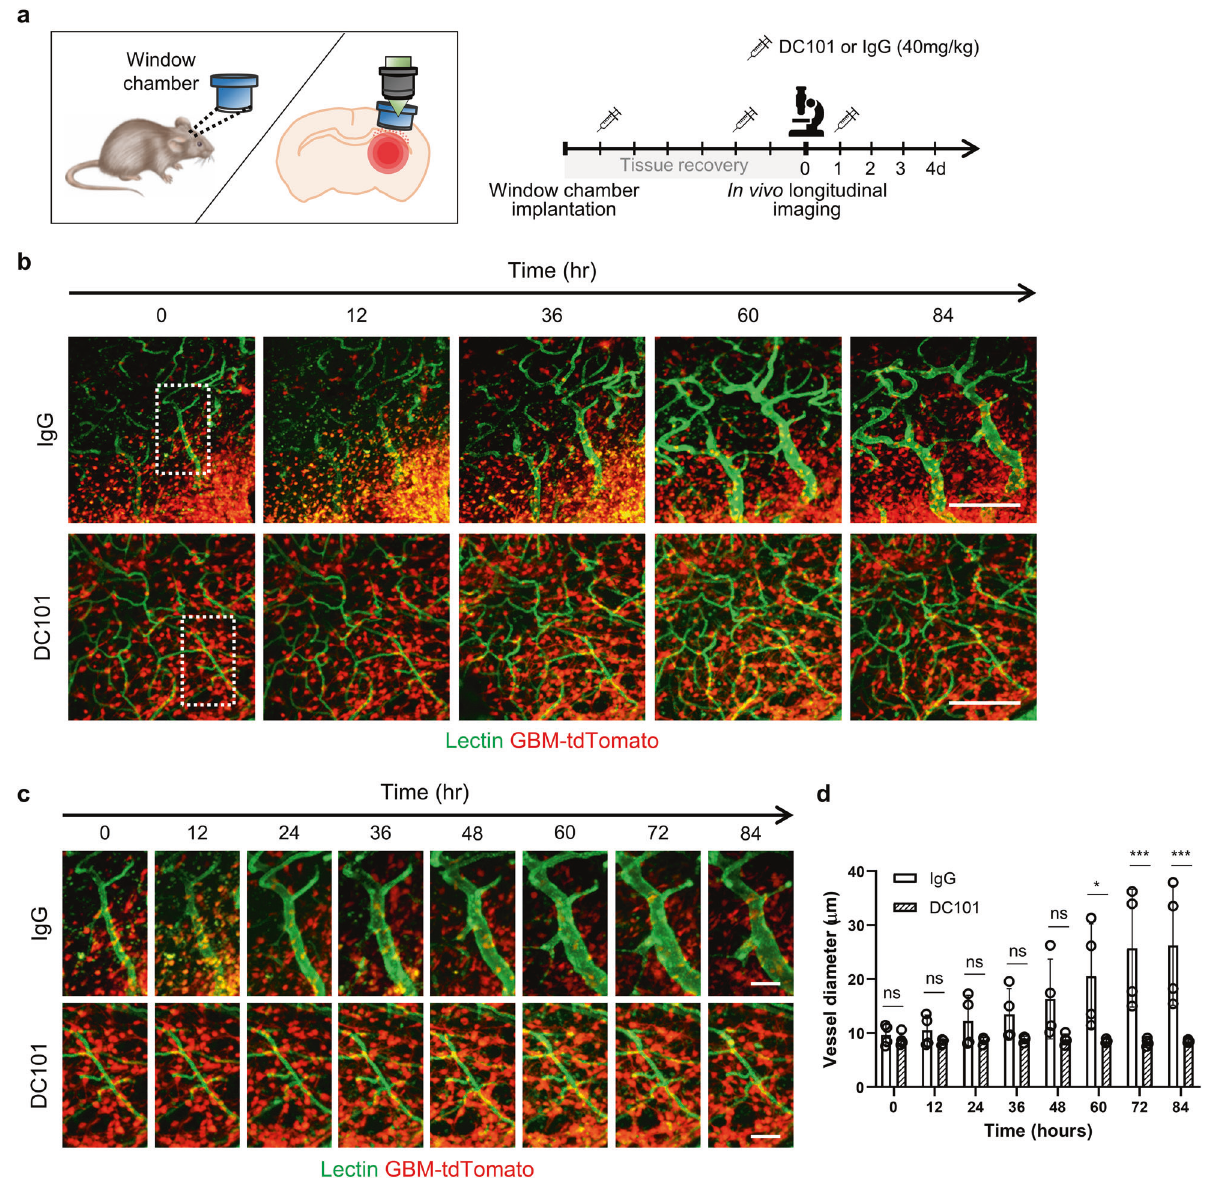
Fig. 3 Progressive vasodilation associated with GBM invasion depends on VEGFR2 signaling. a Schematic showing the cranial window chamber and experimental schedule with antibody treatment for intravital imaging. b – d Longitudinal vascular images in EGFR VIII GBM after control IgG or DC101 treatment. Vessels were stained for perfused lectin. c Magni fi ed images of the boxed area in ( b ) at a shorter time interval. d Quanti fi cation of vessel diameter in IgG-treated ( n = 4) and DC101-treated ( n = 4) mice. Scale bars: 200 µm ( b ), 50 µm ( c ). ns not signi fi cant; *, P < 0.05; ***, P <